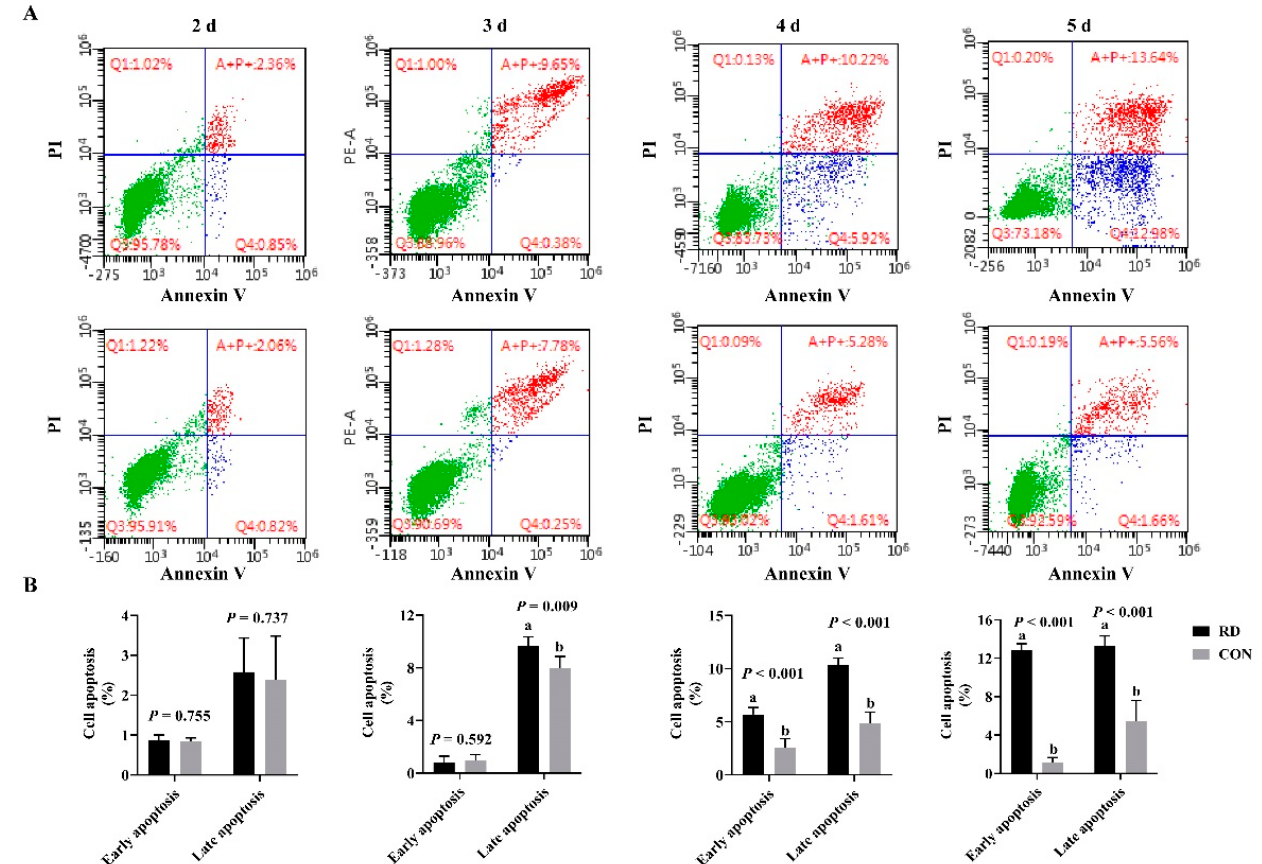
Figure 4. RD-induced cell apoptosis. ( A ) Cellular apoptosis determined by flow cytometry. ( B ) Re- sults of cell apoptosis analysis. Different letters indicate significant differences ( p < 0.05). Each treatment is performed in six replicates ( n = 6).